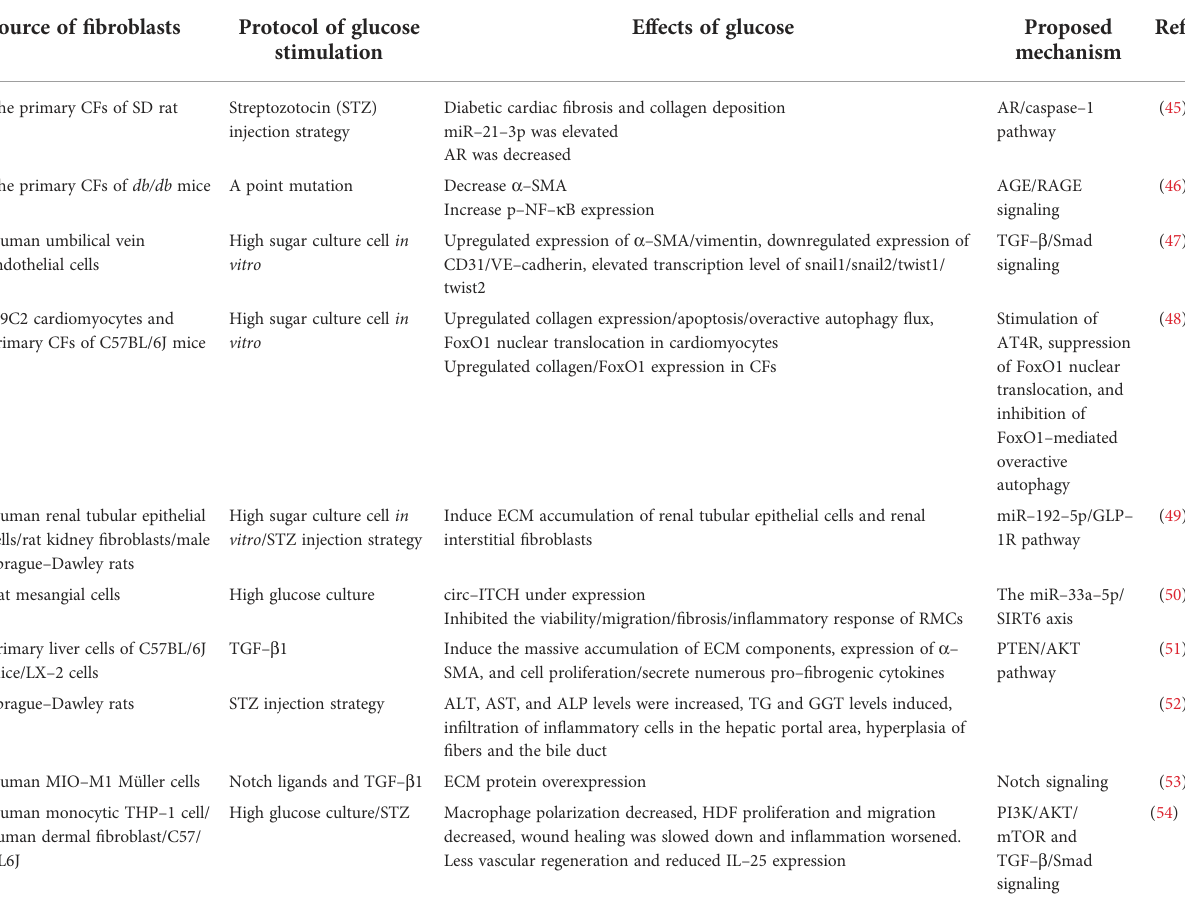
TABLE 1 Summary of experimental studies on diabetic fi brosis.